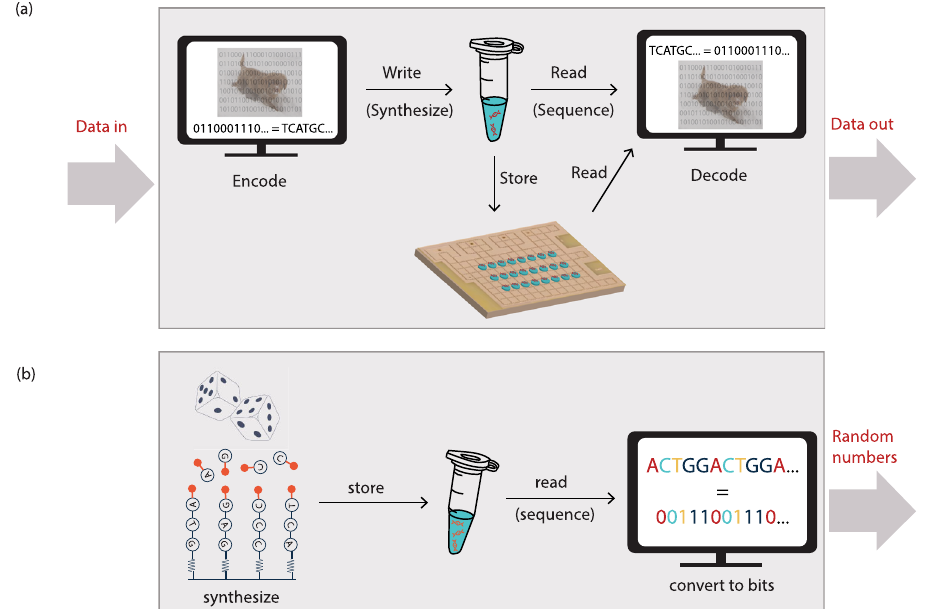
Fig. 3 Integrating DNA synthesis and sequencing into digital information processes. a Storing information in DNA. The bits composing a digital fi le are translated to DNA nucleotides, which can then be synthesized using array-based synthesis technology and stored. To retrieve the fi le, DNA is ampli fi ed using PCR and sequenced. b Process of random number generation. DNA strands are synthesized with nucleotides being added randomly to the growing strands. The random number can then be physically stored in a tube containing the DNA and subsequently read by sequencing technologies. Post- processing steps ensure that the synthesized number is truly random when converted into